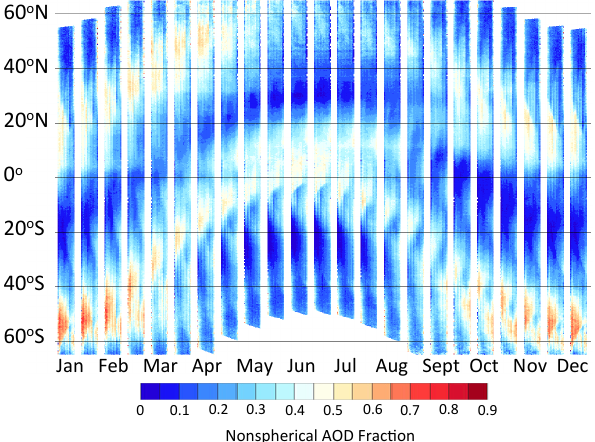
Fig. 8. Climatology of MISR non-spherical AOD fraction over ocean for all AODs averaged over 12 years (March 2000– February 2012) presented in the same manner as Fig.